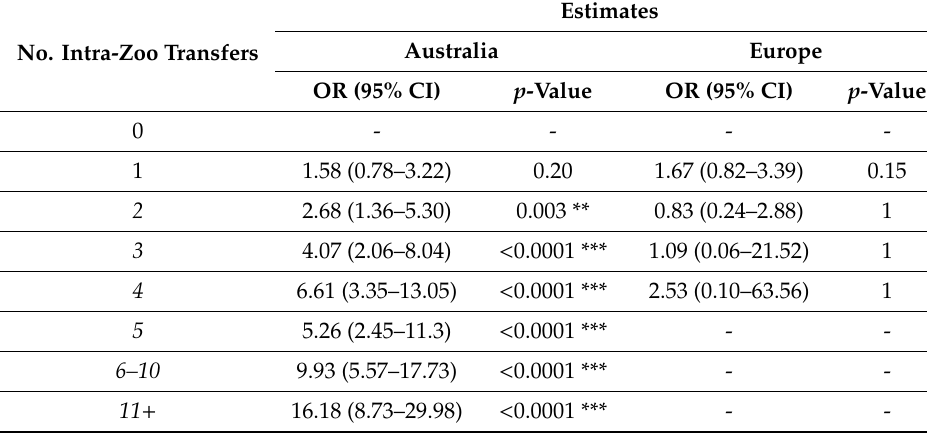
Table 5. Odds ratios for intra-zoo transfers in relation to risk of developing MPPD in macropods housed in zoological institutions in the Australian and European regions between 1 January 1995 and 28 November 2016. Reference category: macropods that had no intra-zoo